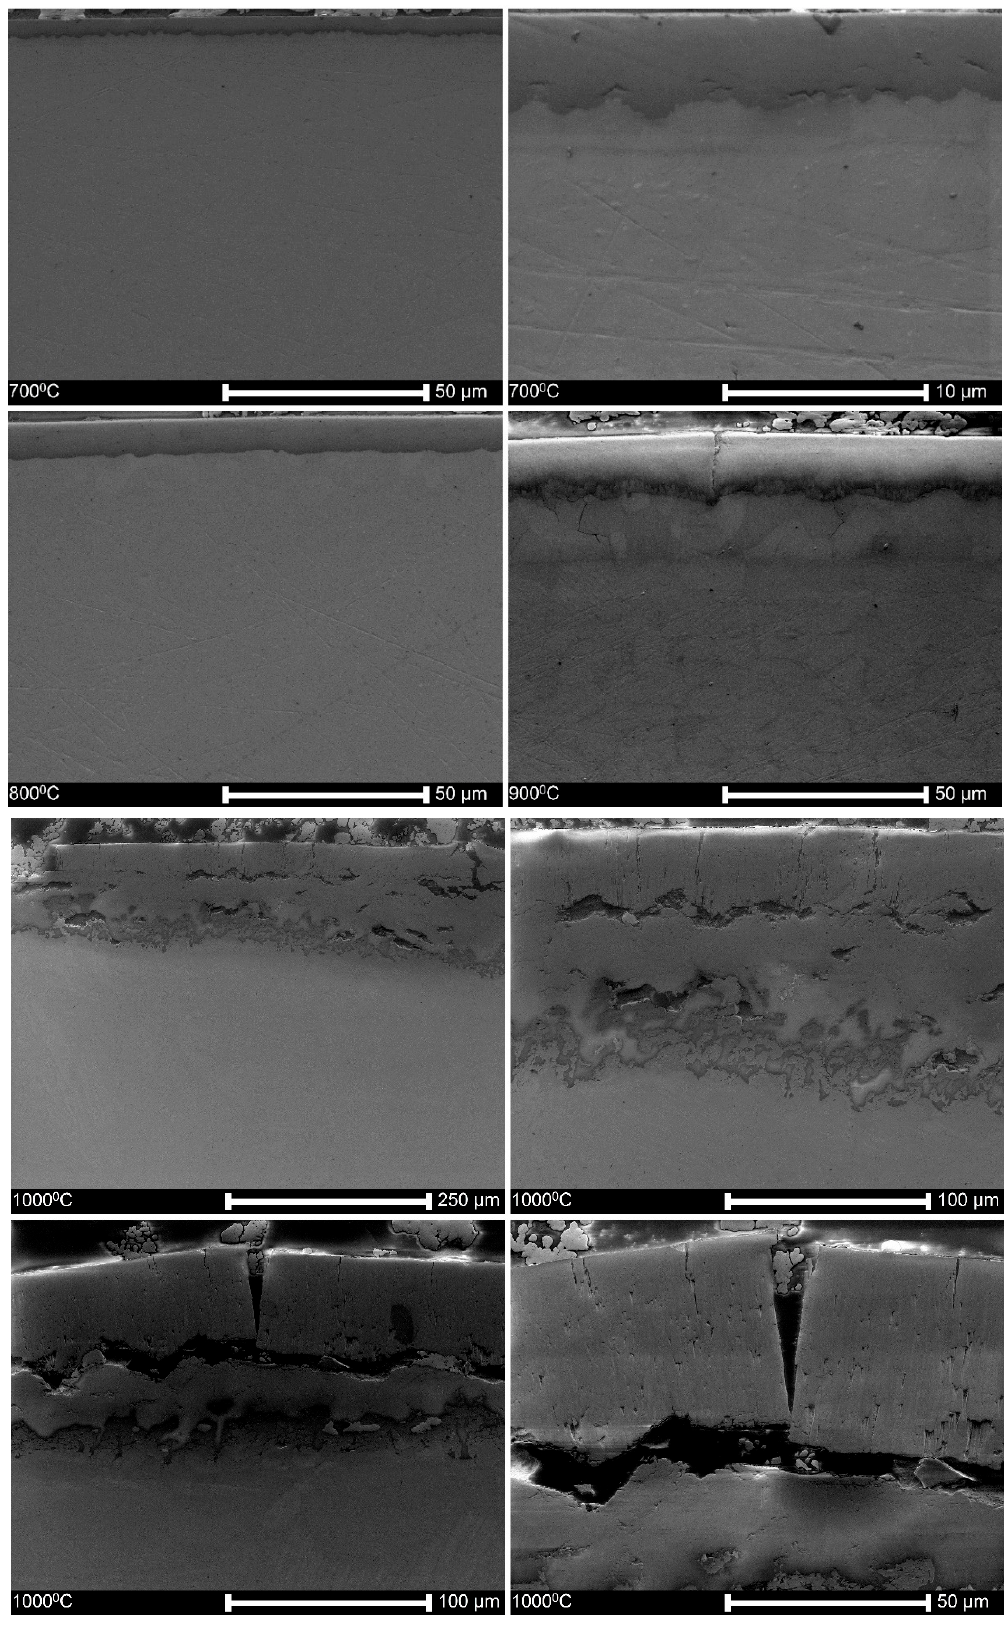
Figure 2. The cross-sections of the oxide layers obtained at different temperatures, between 500 °C and 1000 °C, as shown in each photo.